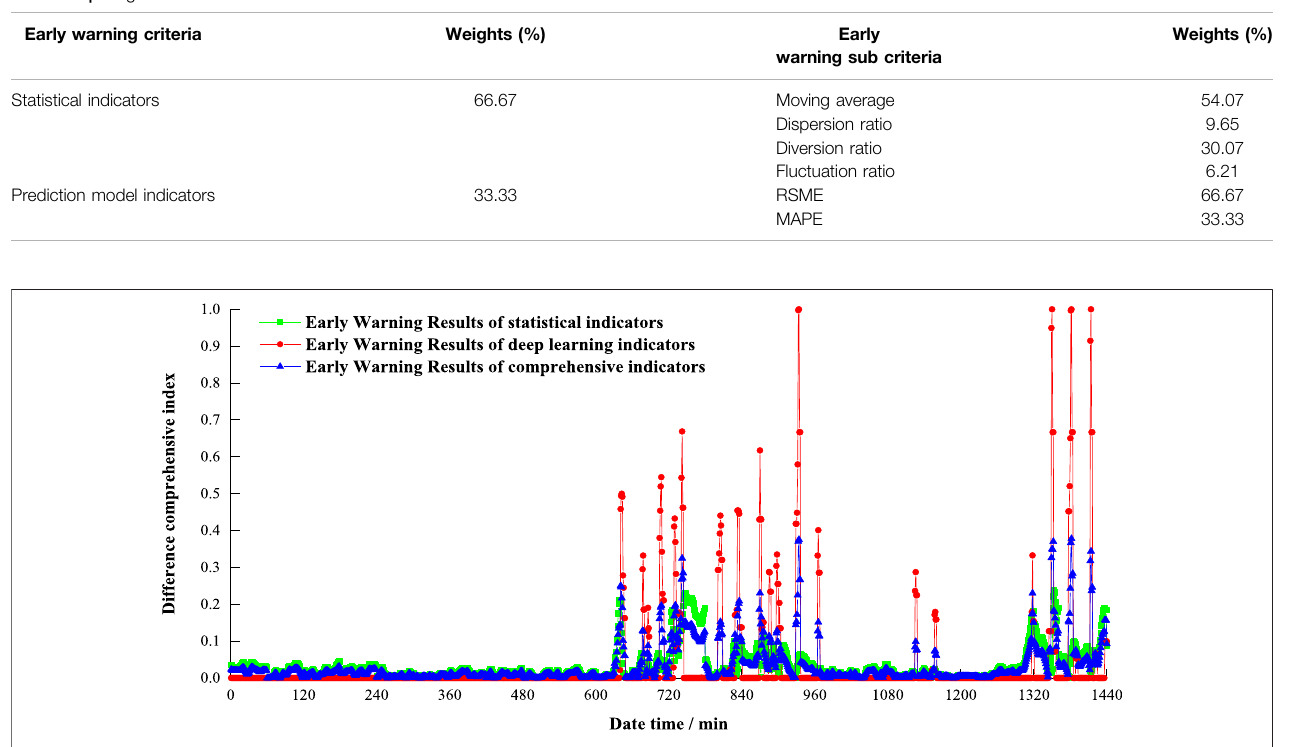
TABLE 1 | Weights of all criteria and sub criteria.